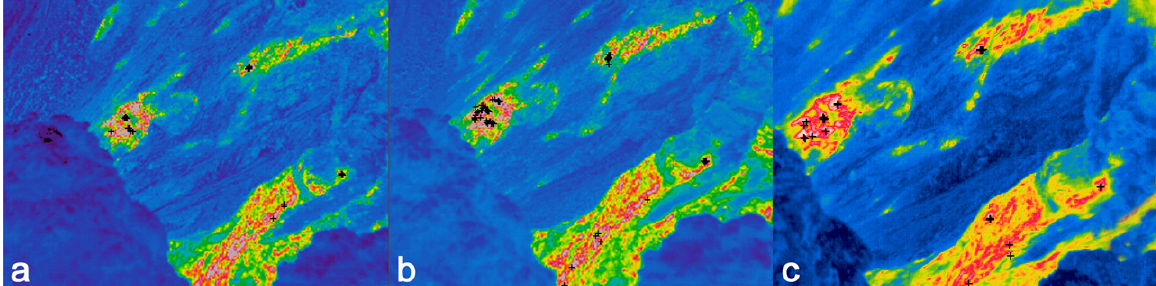
Figure 10. Location of the maximum temperature pixels (black crosses) of the three IR image time series belonging to the three different acquisition periods. Little differences between images a and b and the image c are due to change in camera type (NEC for a and b, FLIR for c image) and different software used to display IR image data.